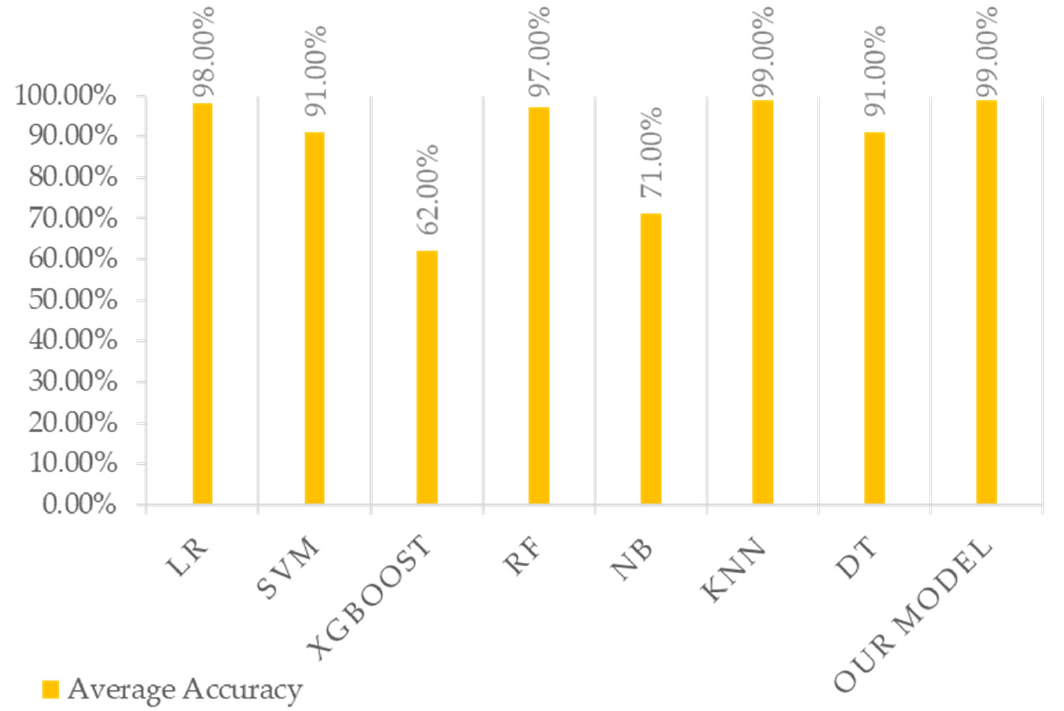
Figure A4. Comparison of the accuracy of our model with different algorithms.